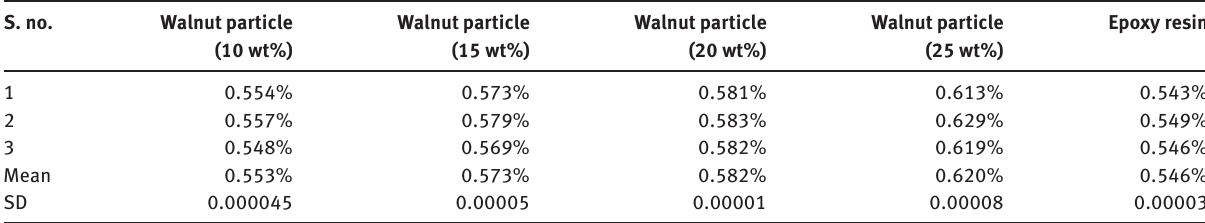
Table 2 Water absorption